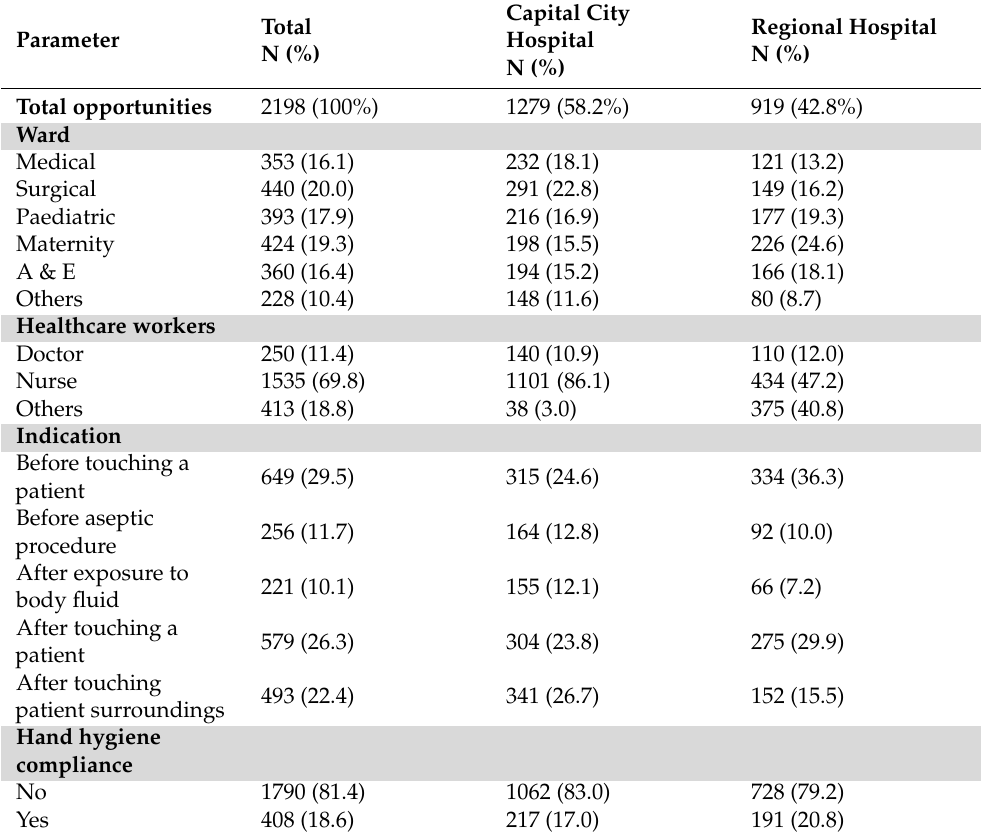
Table 3. Observed hand hygiene (HH) opportunities in the two